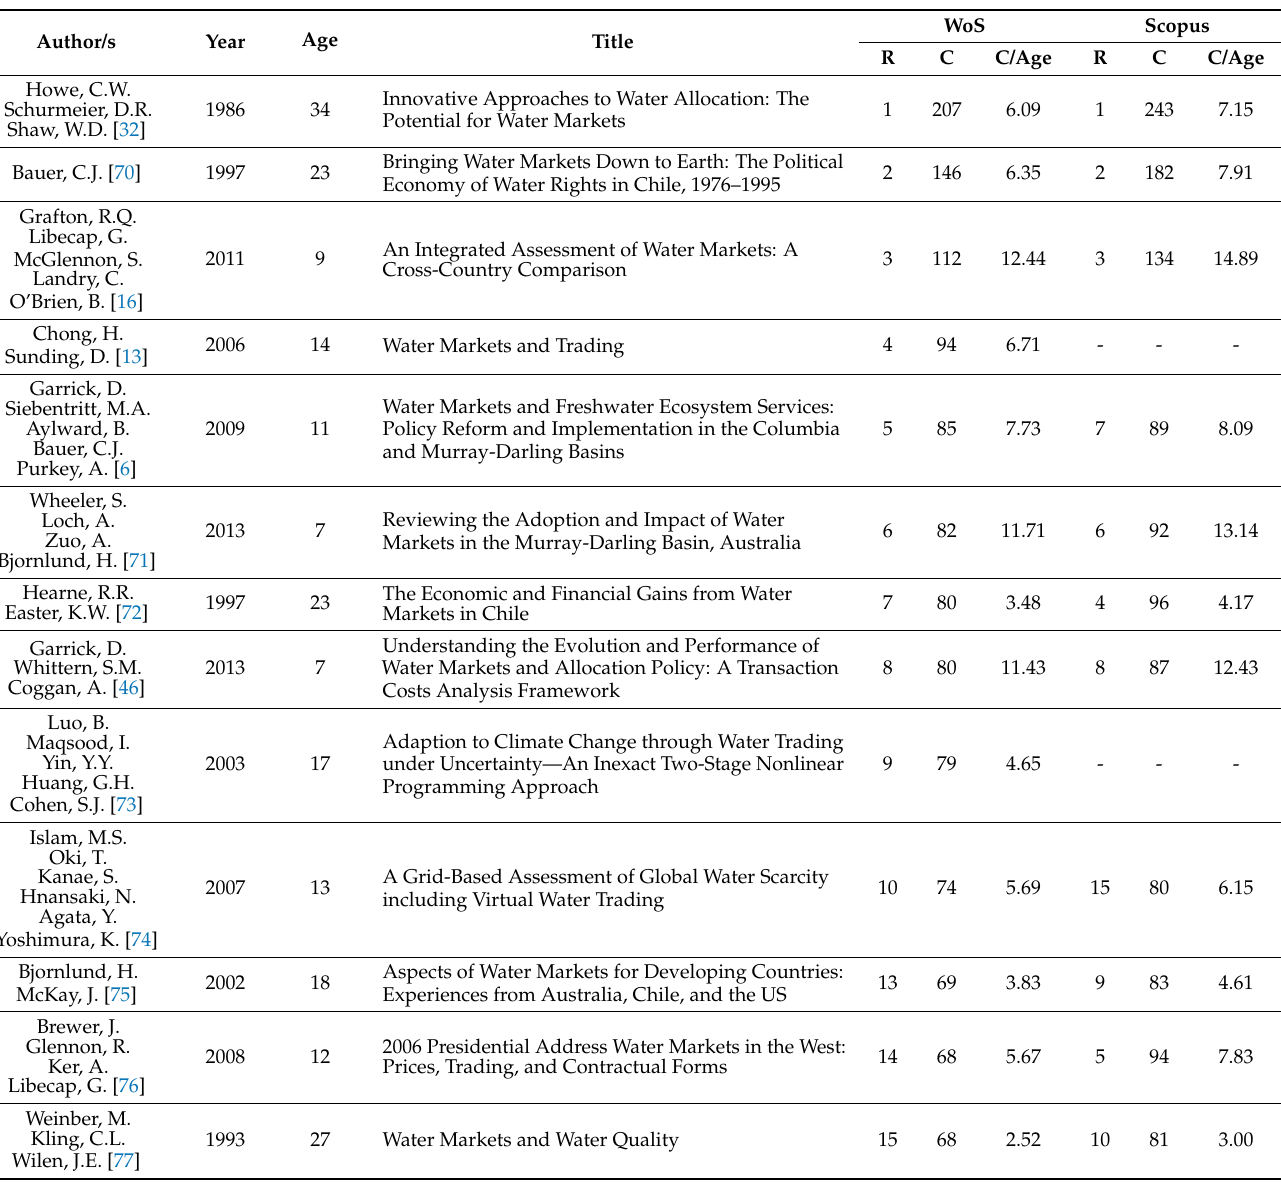
Table 7. Ranking of the most-cited articles on the Water Market in the WoS and Scopus